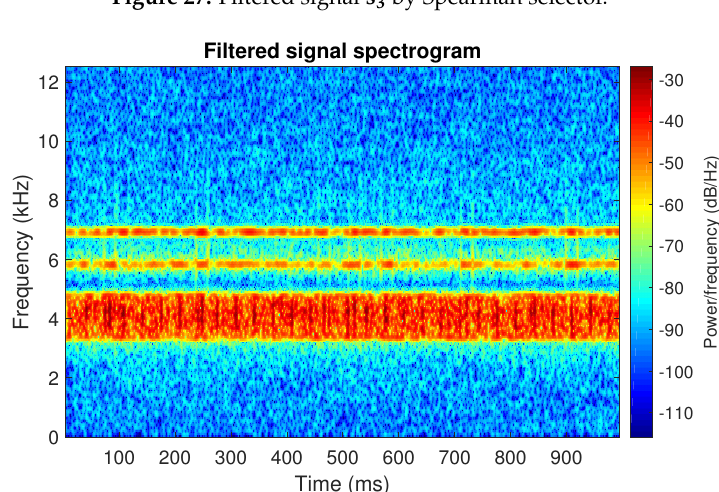
Figure 27. Filtered signal s 3 by Spearman selector.